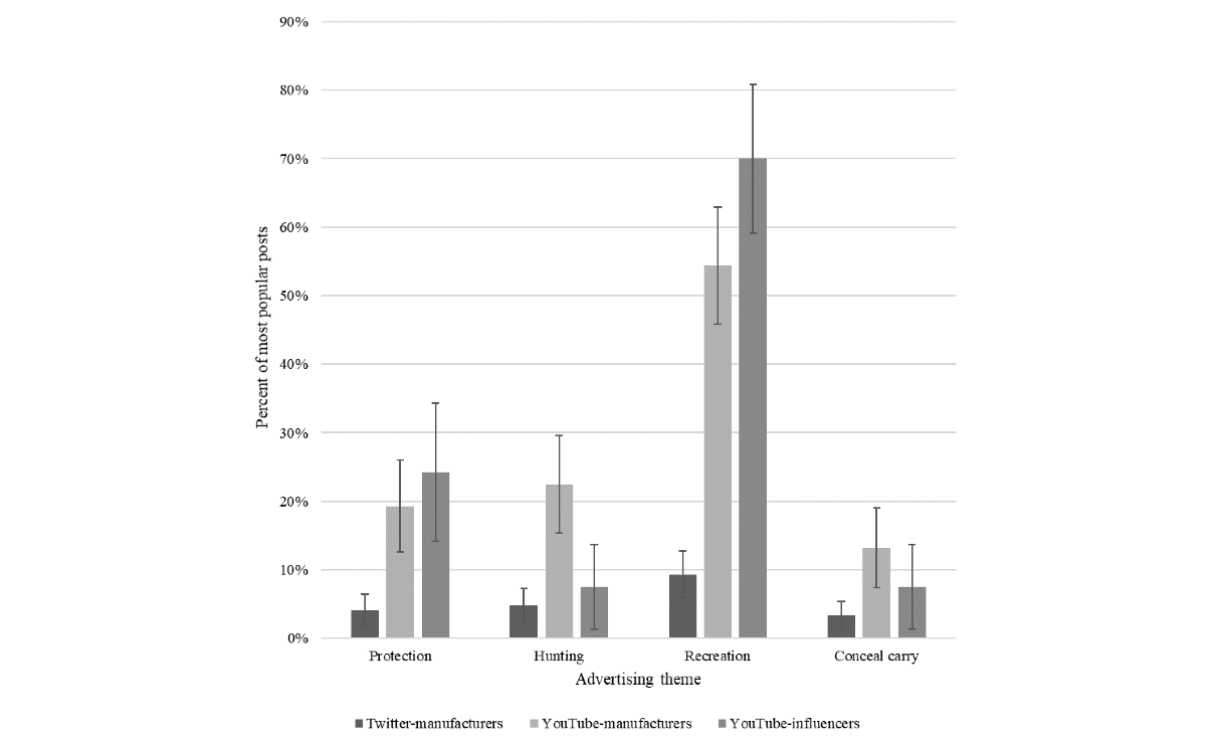
Figure 1. Suggested use for guns by most popular posts (1% CIs